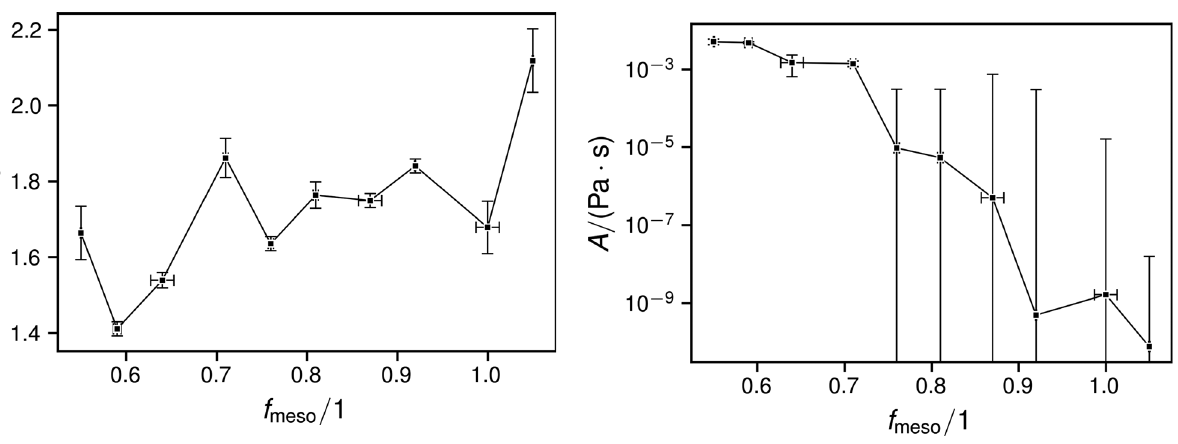
Figure 7: Doolittle scaling parameters.